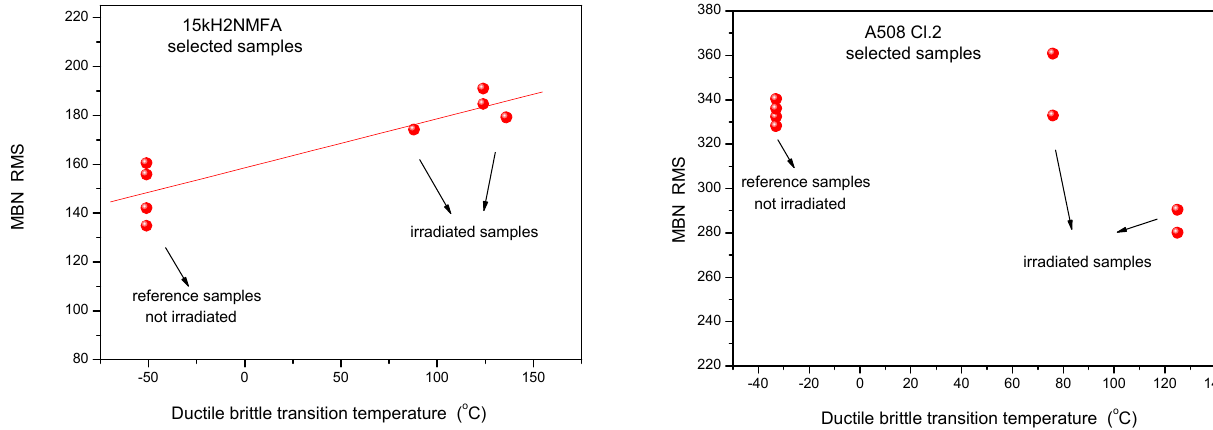
Figure 13. MBN RMS parameter as a function of transition temperature for selected 15kH2NMFA and A508 Cl.2 samples.